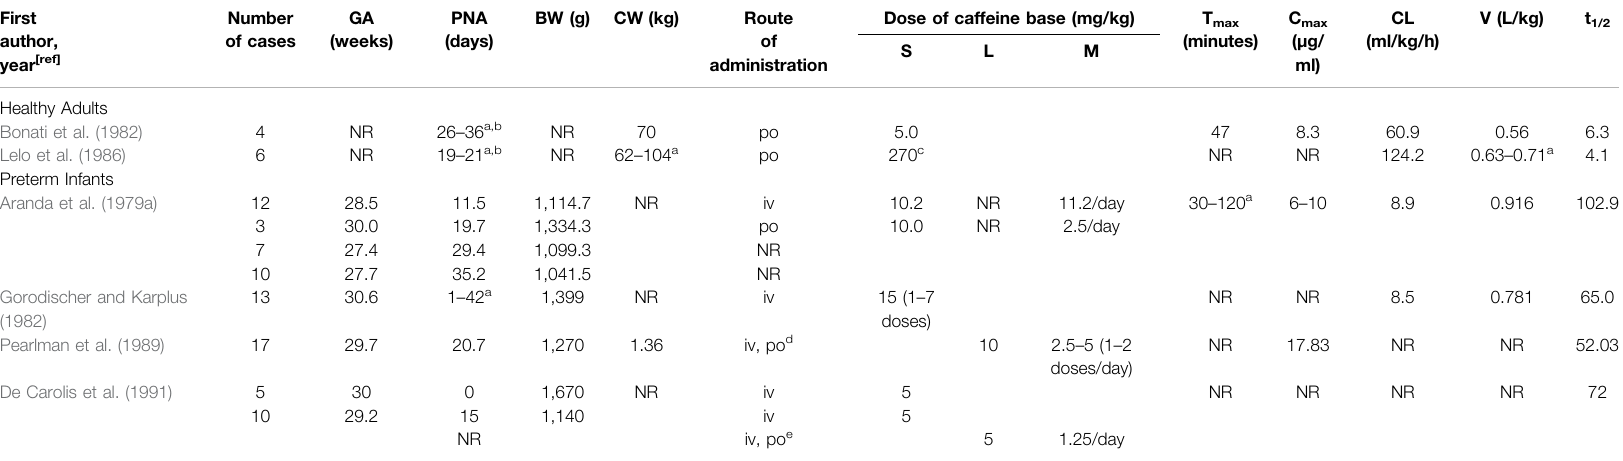
TABLE 1 | Pharmacokinetics of caffeine in healthy adults and preterm